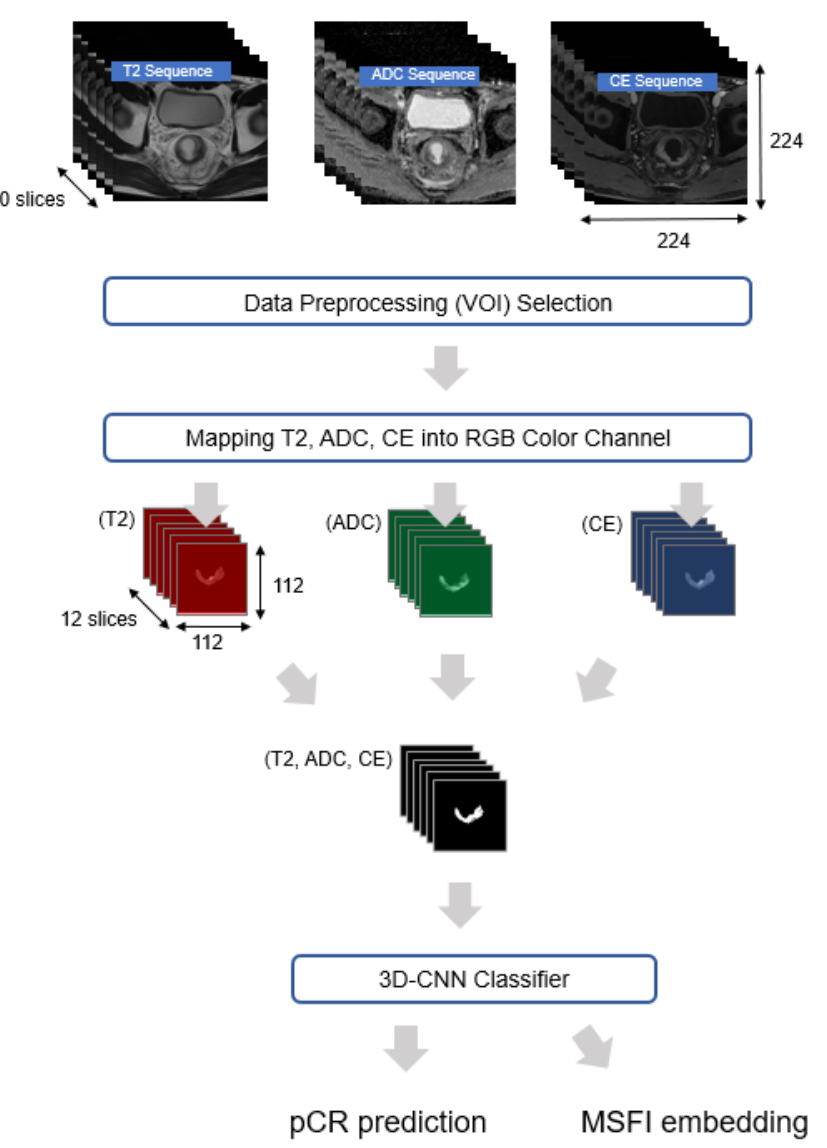
Figure 2. The pCR prediction process using the 3D-CNN classifier from which we extract MSFI embedding, given { T2, DWI/ADC, and CE } MRI